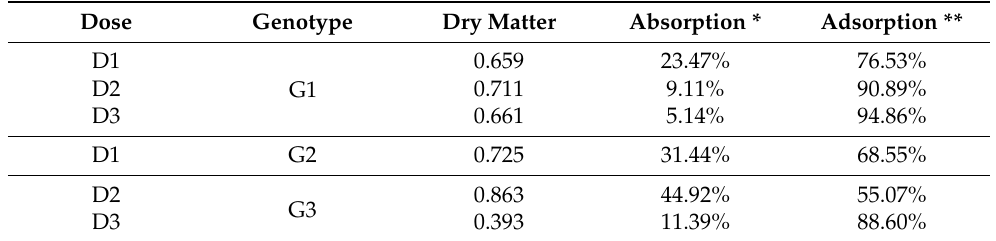
Table 6. Percentages of absorption and adsorption of Ni by the seedling and zeolite 5A. Dose Genotype Dry Matter Absorption * Adsorption **